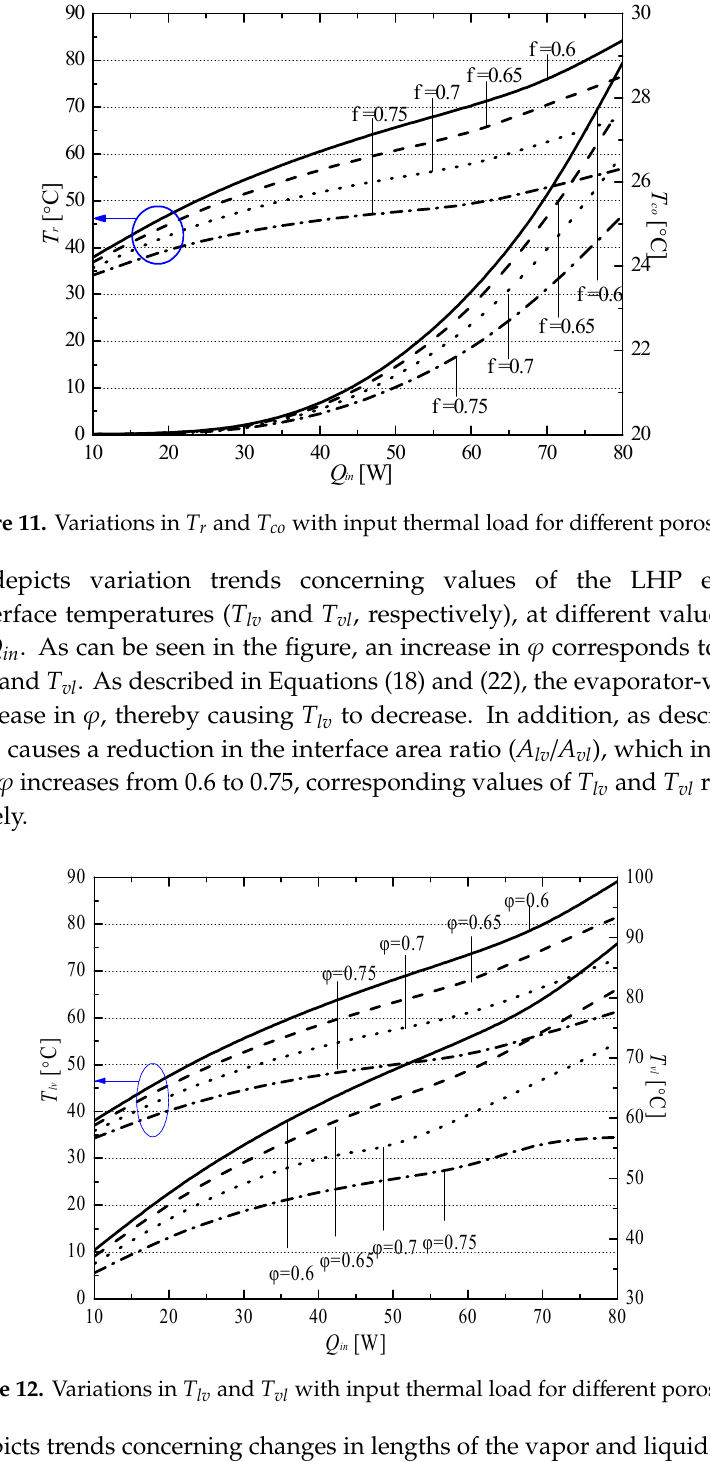
Figure 10. Variations in Q lv and Q leak with input thermal load for different porosities.